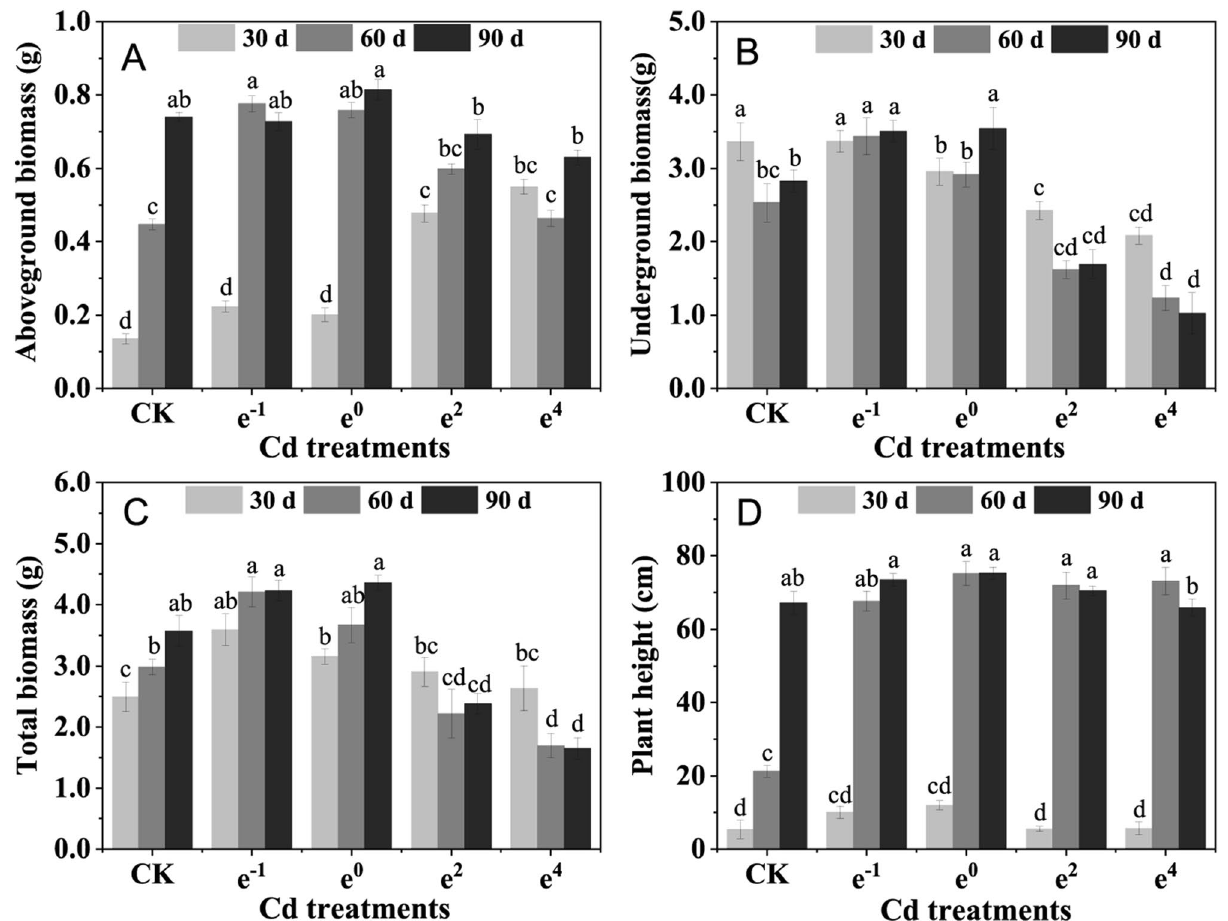
Figure 1. The biomass of Polygonatum sibiricum under different Cd stresses. ( A ) Aboveground biomass (including roots and rhizomes); ( B ) Underground biomass (including stems and leaves); ( C ) Total biomass; ( D ) Plant height. Each value represents the mean ± standard deviation of three independent experiments. Different letters above the bars represent significant differences ( p <